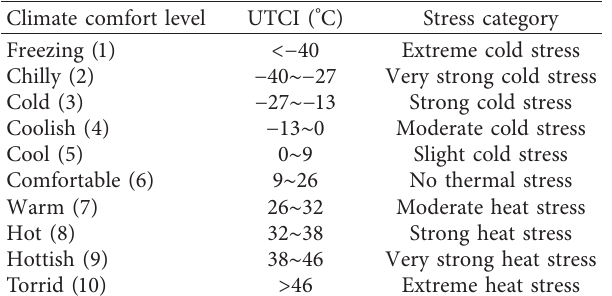
Figure 1: Distribution of meteorological stations in the mainland of China. Table 1: UTCI equivalent temperatures in terms of thermal stress and climate comfort level [32].